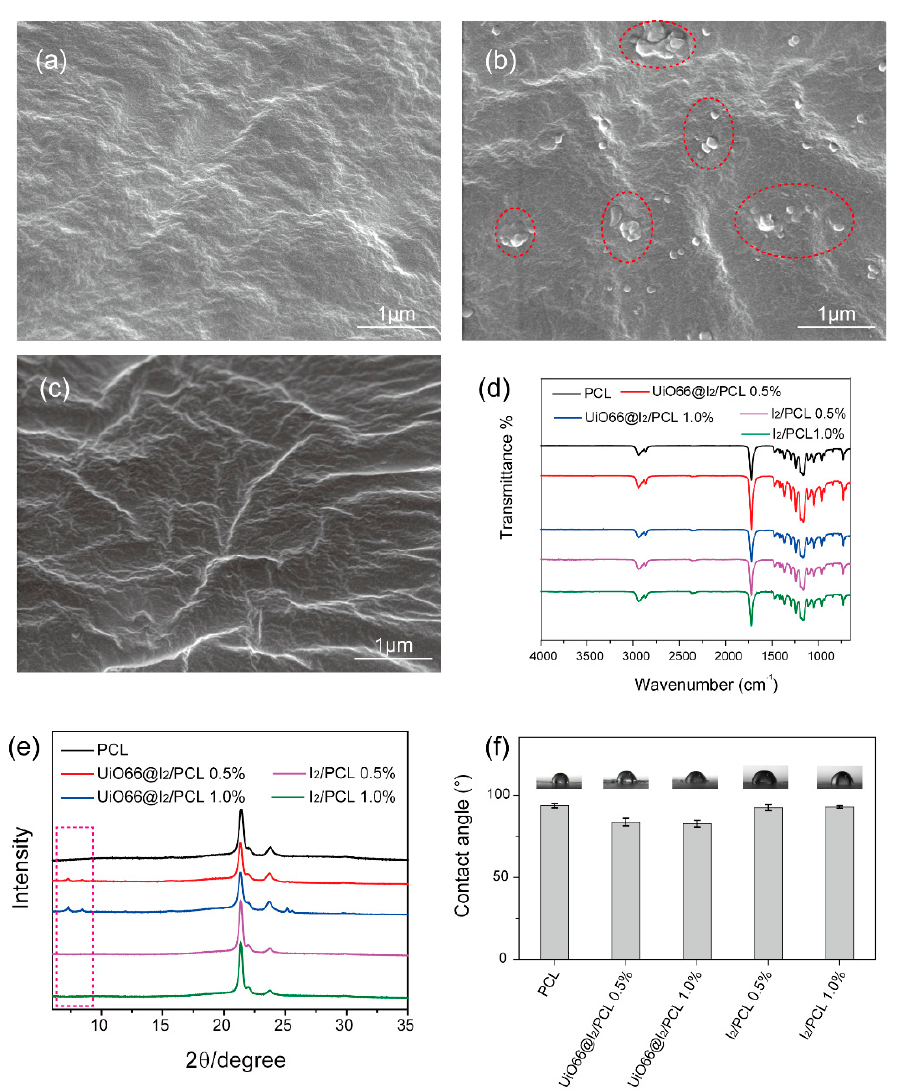
Figure 2. SEM images of ( a ) PCL, ( b ) UiO66@I 2 /PCL, and ( c ) I 2 /PCL composites. ( d ) FTIR spectra of PCL, UiO66@I 2 /PCL, and I 2 /PCL composites. ( e ) XRD pattern of PCL, UiO66@I 2 /PCL, and I 2 /PCL composites. ( f ) Static water contact angles of PCL, UiO66@I 2 /PCL, and I 2 /PCL composites.